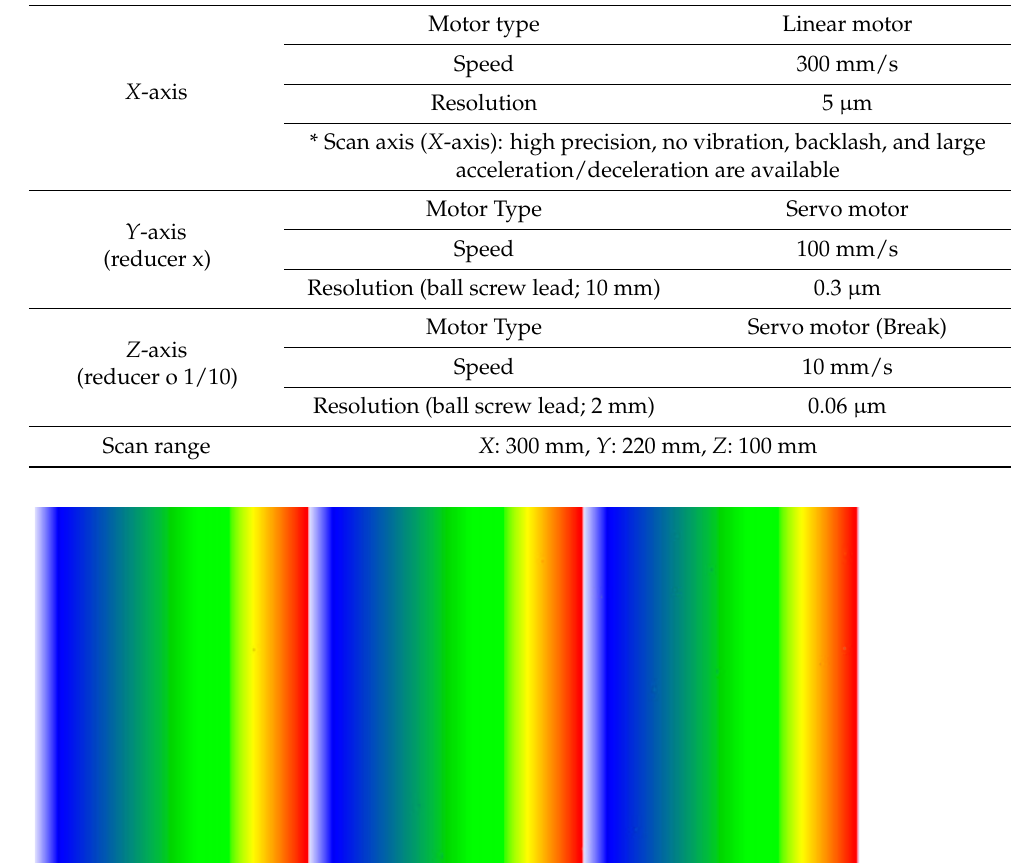
Figure 5. X-axis performance verification. Figure 5. X -axis performance